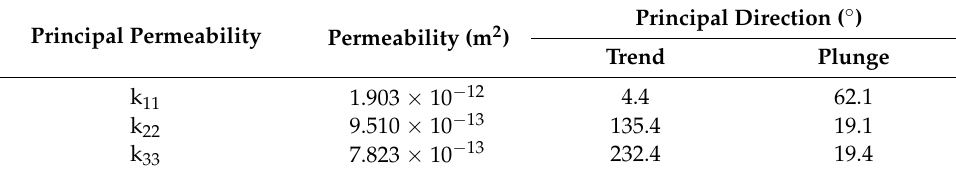
Table 3. Principal permeability tensor derived for the DFN